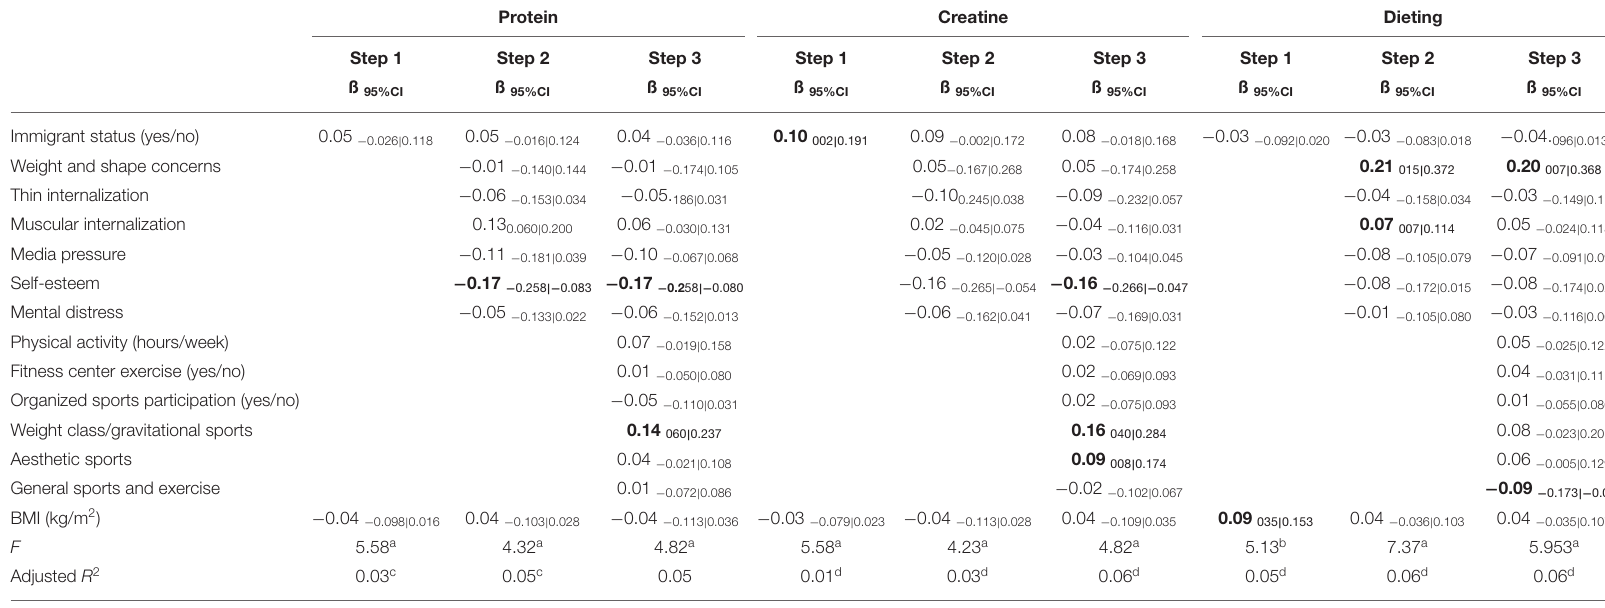
TABLE 4 | Bootstrapped hierarchical linear regression analysis of variables explaining the variance in girls’ ( n = 1,060) weekly (0–7) use of protein, creatine, and dieting supplements, respectively.